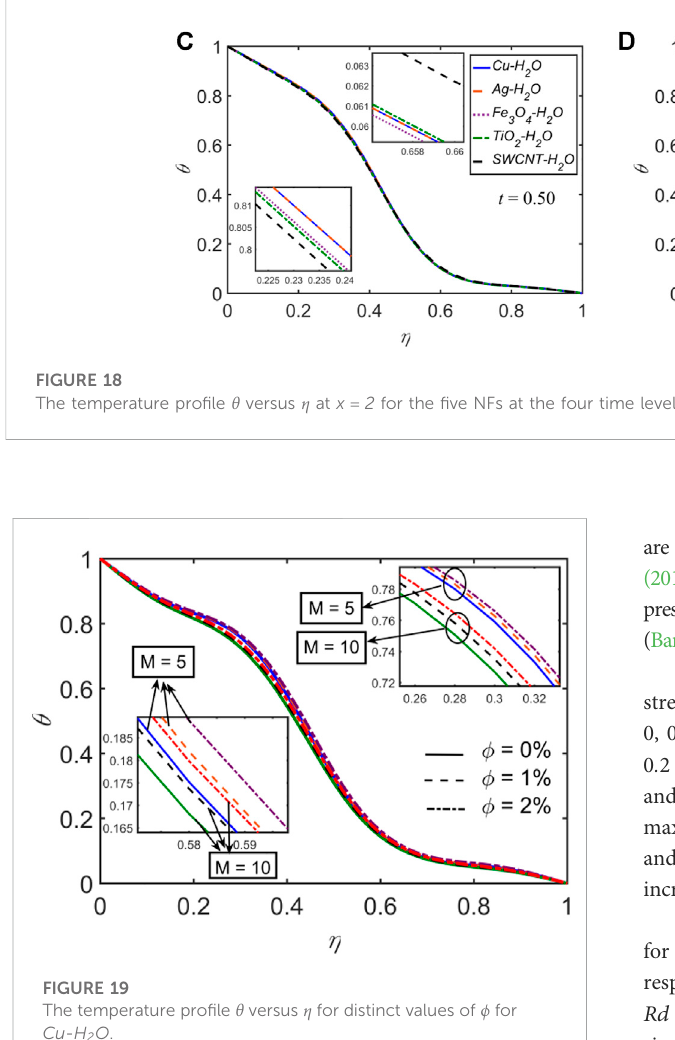
The temperature pro fi le θ versus η for distinct values of ϕ for Cu - H 2 O the lee of the constriction) where the fl uid has entered in the low-pressure zone from the high-pressure zone. For a pulse cycle, 0 < t < 0 . 25 is the acceleration phase, and 0 . 25 < t < 0 . 75 is the deceleration phase.